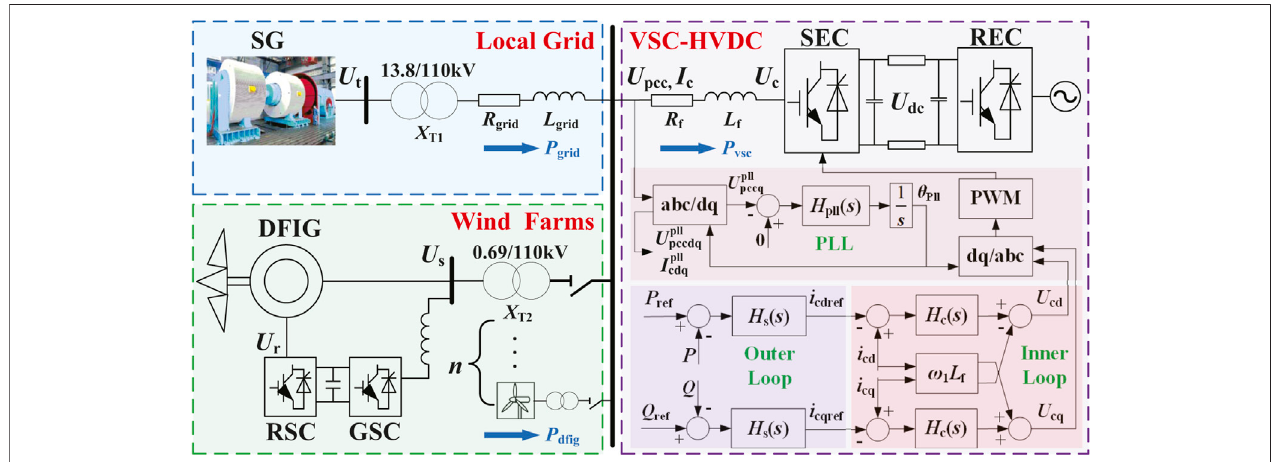
FIGURE 1 | VSC-HVDC connected to the local grid and DFIG-based wind farms.